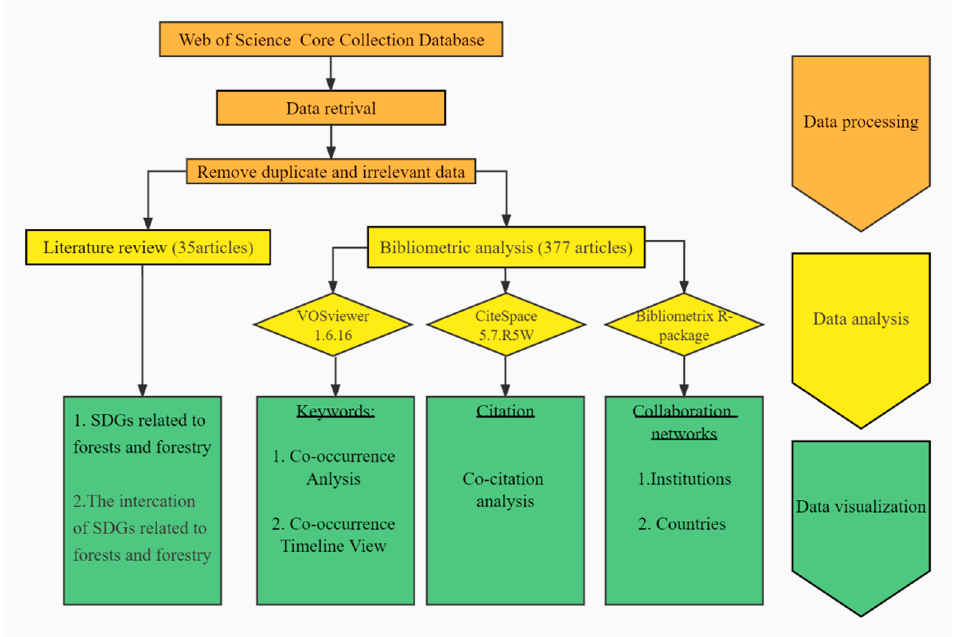
Figure 1. Research framework design .